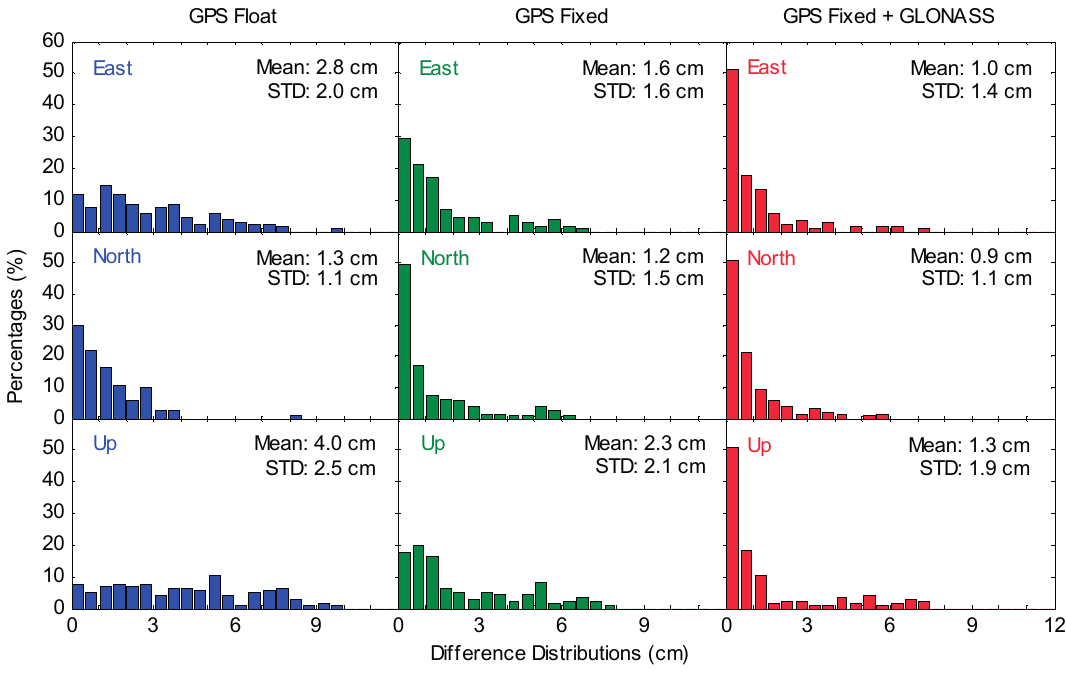
Figure 8. Distributions of positioning errors for GPS ambiguity-float PPP, GPS ambiguity-fixed PPP and GGPPP-FGA processing in eight sessions using datasets collected at 20 IGS stations on two consecutive days. The distributions in the east, north and up components are displayed in the top , middle and bottom panels,